Question: Sum up the contents of this chart in one sentence.
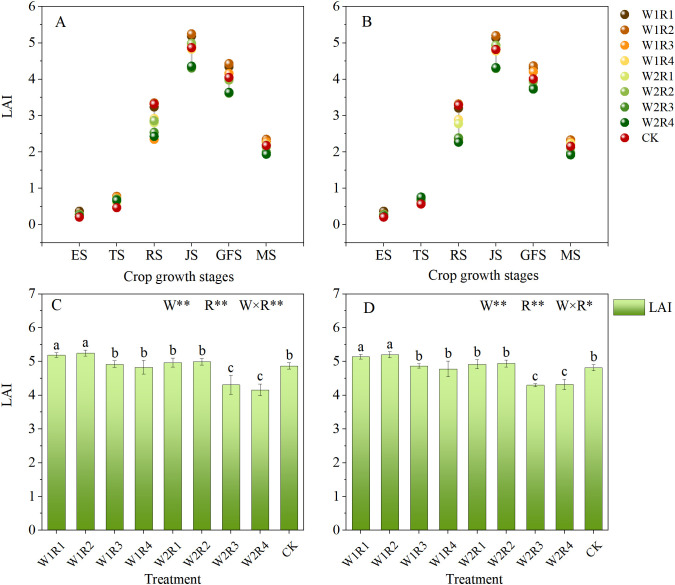
Answer: Characteristics of changes in leaf area index during the growth stages of winter wheat in 2023-2025. (A, B) show the changes in leaf area index of winter wheat as the growth stages progressed in 2023–2024 and 2024-2025, respectively. (C, D) show the histograms of the analysis of variance (ANOVA) for leaf area index at the jointing stage in 2023–2024 and 2024-2025, respectively; Lowercase letters indicate significant differences among treatments (p< 0.05); W, real-time irrigation level; R, fertilizer-pesticide treatment; *p< 0.05, **p< 0.01.